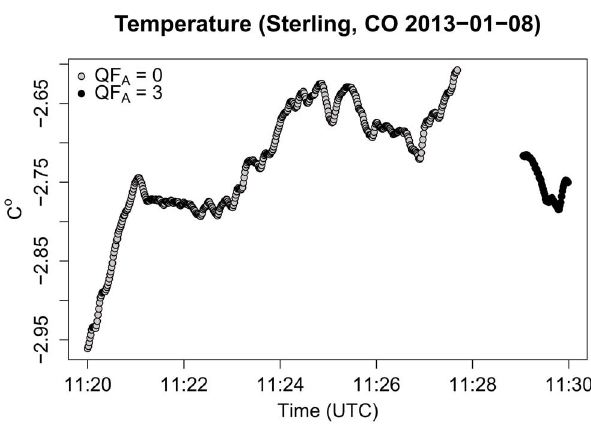
Figure 3. TRAAT from the NEON Sterling CO site, each circle indicates an averaged 1 Hz sensor measurement. The open gray circles indicate that the average of the 3 PRTs was used in the TRAAT calculation. Alternatively, the full black circles indicate that the TRAAT 1 Hz sensor measurement was calculated as the average of PRT 1 and PRT 2, i.e., averaging flag set to 3 in Table 1.